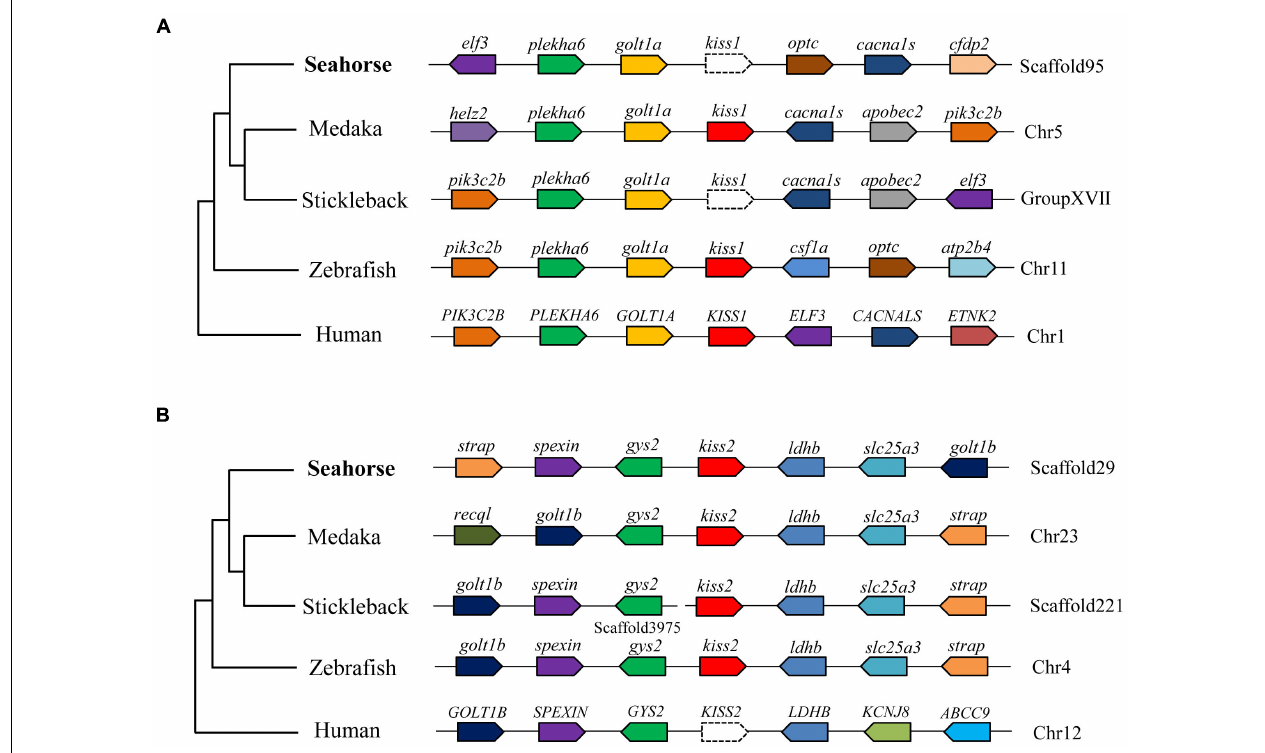
FIGURE 4 | Conserved synteny for the genomic region comprising kiss1 (A) and kiss2 (B) genes. Gene loci organizations in the genomic region containing the kisspeptin gene were obtained from the Ensembl genome browser